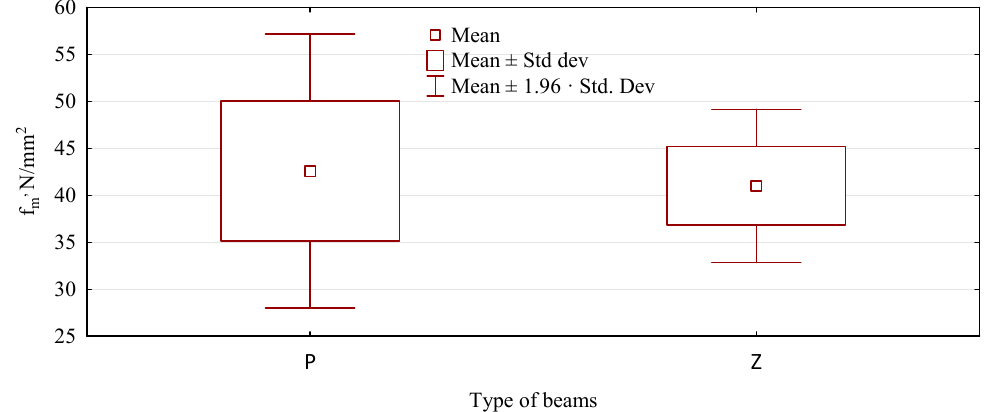
Figure 4. Static bending strength of pine beams.